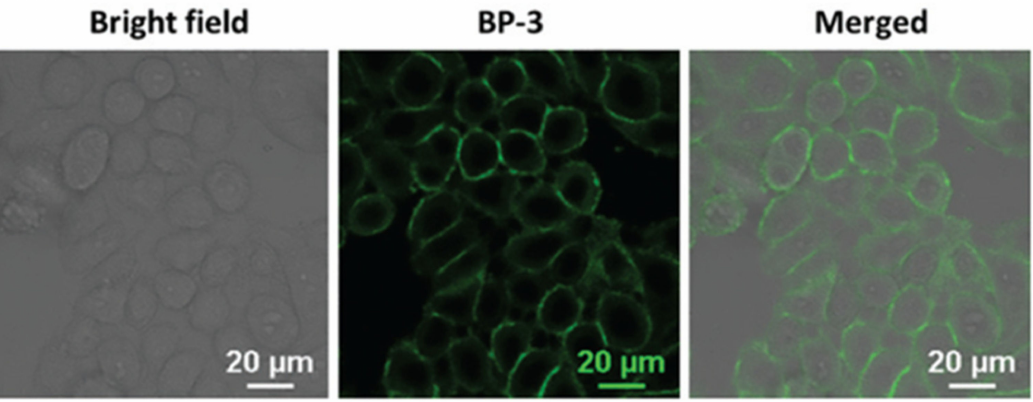
Figure 18. Fluorescence images of MCF-7 cells stained with probe 7 (10 µ M). Scale bar: 20 µ m [59].